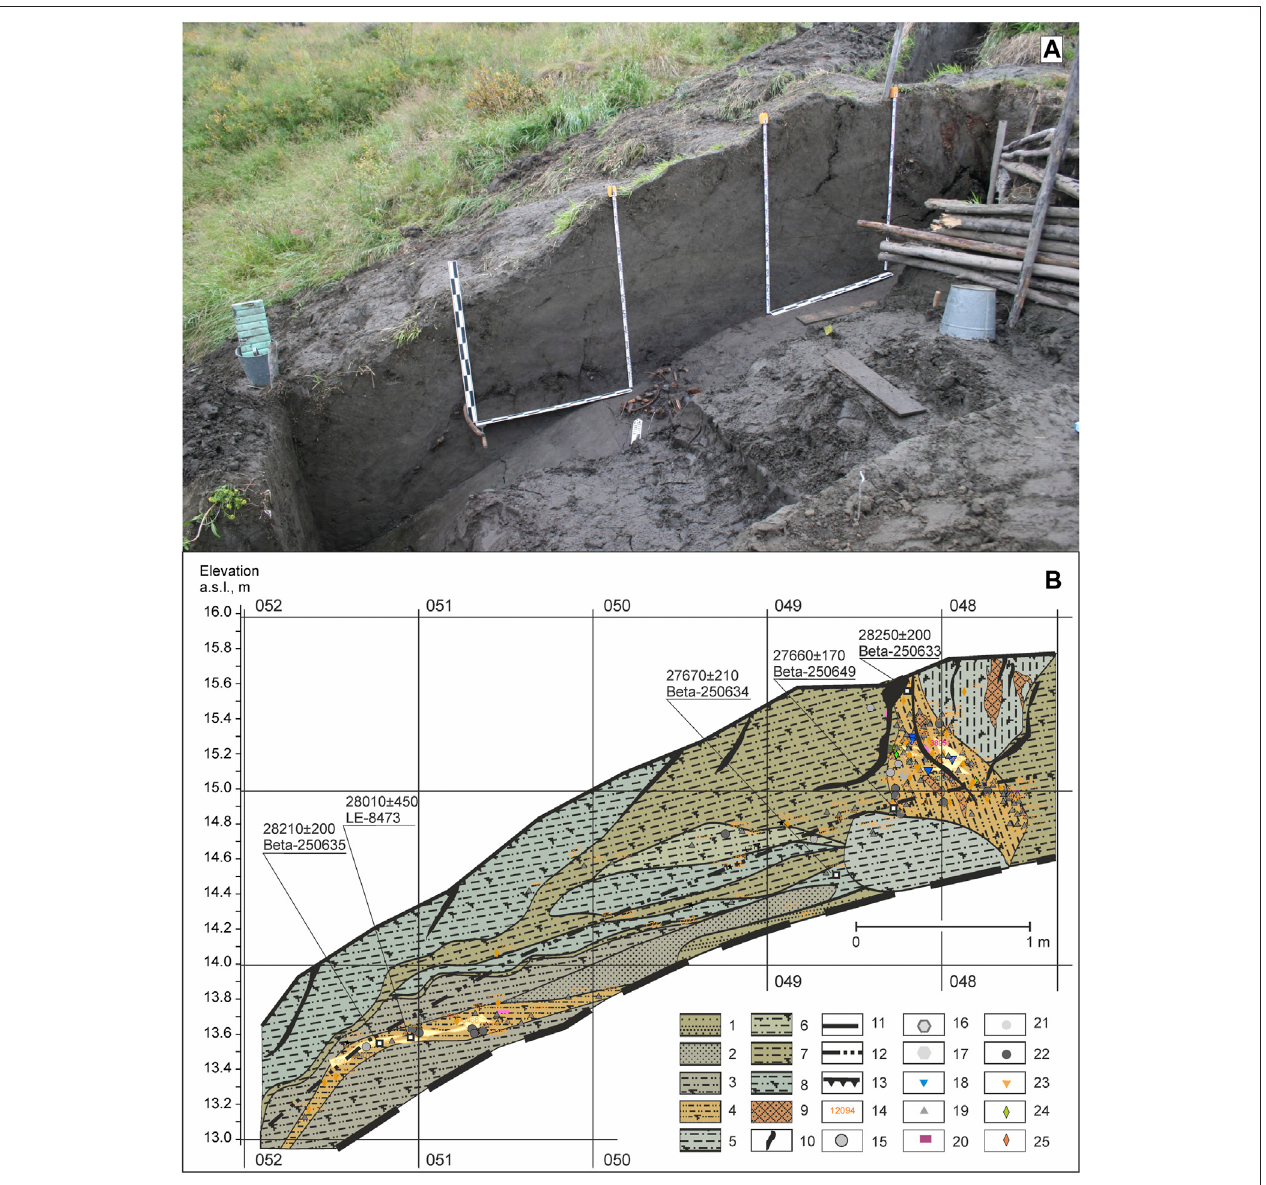
FIGURE 12 | Yana site complex, Yana B area, testing trench on the river bank slope at the Dvoinoy polygon unit (A) and lithology sequence observed in the NE excavation wall at grid line Q6F052 - Q6F049 (B) . Pro fi le key: 1 — unsorted sand of brownish-gray color; 2 — fi ne-grained sand of gray color; 3 — sandy silt of gray color; 4 — sandy silt of brown color; 5 — silt of gray color; 6 — sandy-clayey silt of brownish-gray color; 8 — clayey silt of light-gray color; 9 — peat lenses; 10 — drying fi ssure; 11 — pro fi le bottom; 12 — STL boundary; 13 — pro fi le edge; 14 — artifact number; 15 — lithic side scraper; 16 — core; 17 — blank; 18 — lithic tool; 19 — fl ake; 20 — blade; 21 — pebble; 22 — burnt rock; 23 — bone tool; 24 — mammoth ivory fragment; 25 — fauna remains. After (Pitulko,